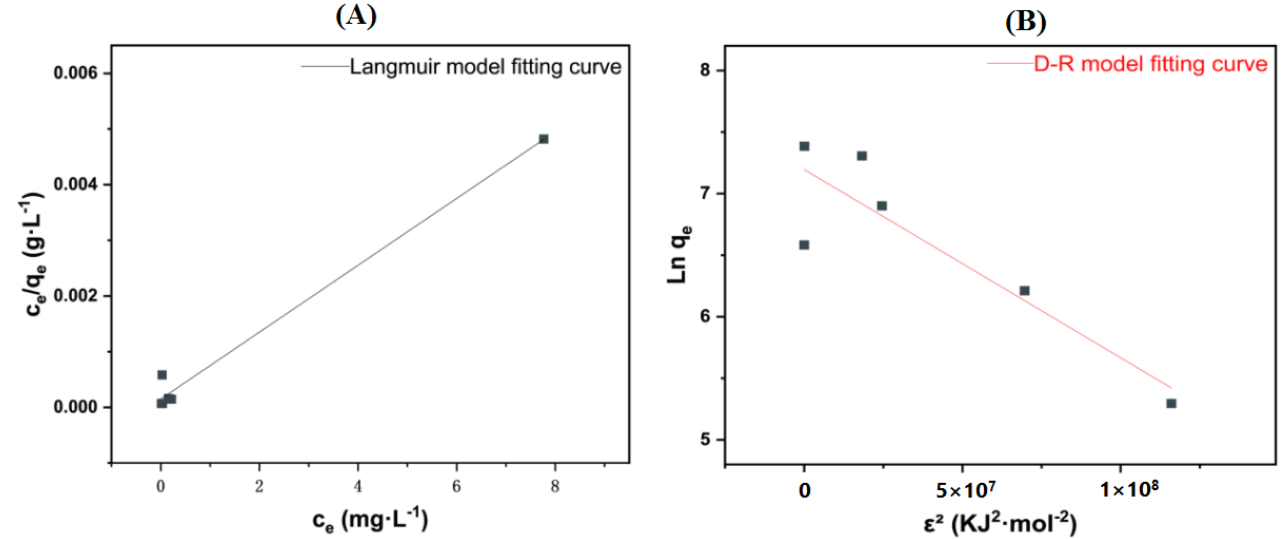
Figure A1. The plots of adsorption kinetics fitted by pseudo-second-order kinetic ( A ), intra−particle diffusion kinetics ( B ) and Bangham modes ( C ). The adsorption of NP (4 mg/L) and PS − MPs (20 μg/mL) of different particle sizes were studied.